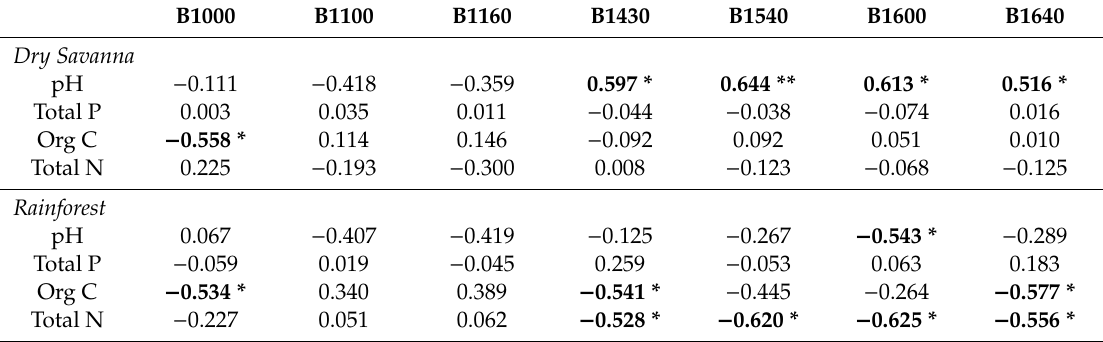
Table 3. Pearson correlation coe ffi cients between the relative intensity of absorbance of ATR-FTIR bands, soil pH and nutrient concentrations for Dry Savanna and Rainforest soils. **, correlation is significant at the 0.01 level (2-tailed). *, correlation is significant at the 0.05 level (2-tailed). B1000 B1100 B1160